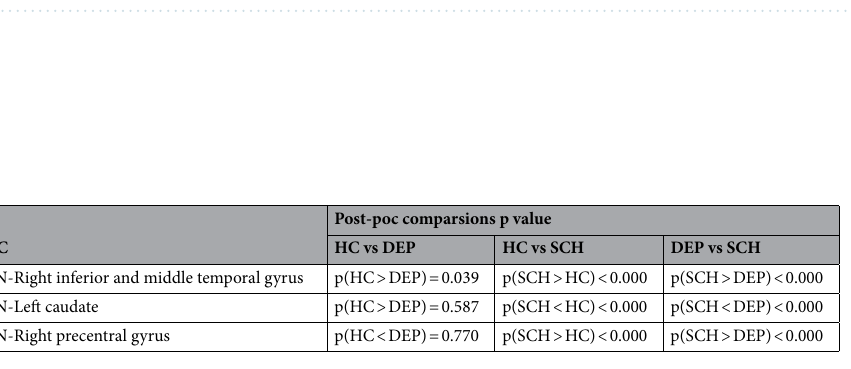
Table 2. Regions with significant group differences in functional connectivity of salience network in three groups. MNI Montreal Neurological Institute, SD standard deviation, ANCOVA analysis of covariance, HC healthy controls, DEP depression, SCH schizophrenia.